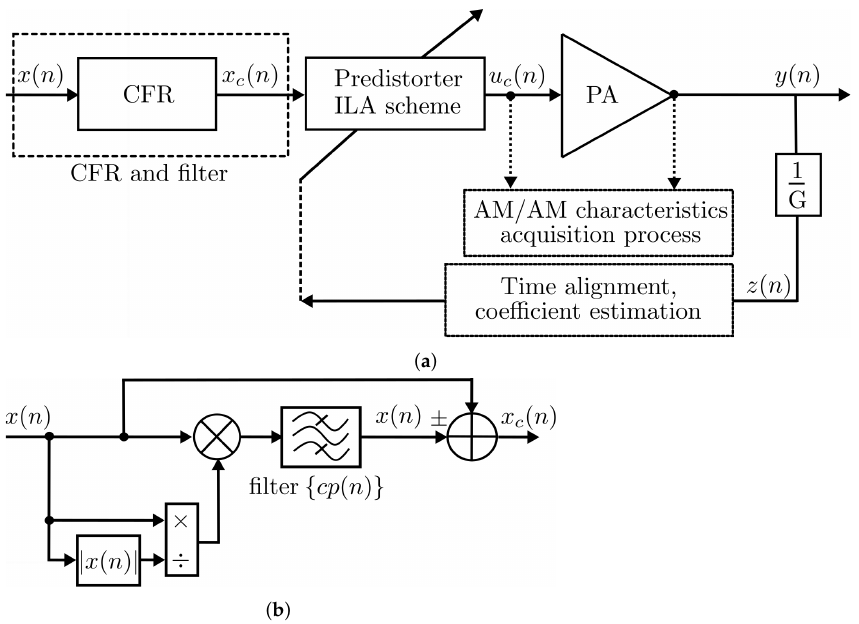
Figure 2. Block diagram of the closed-loop behavioral modeling process with CFR: ( a ) ILA for linearization with CFR clipping reduction, ( b ) CFR and filter